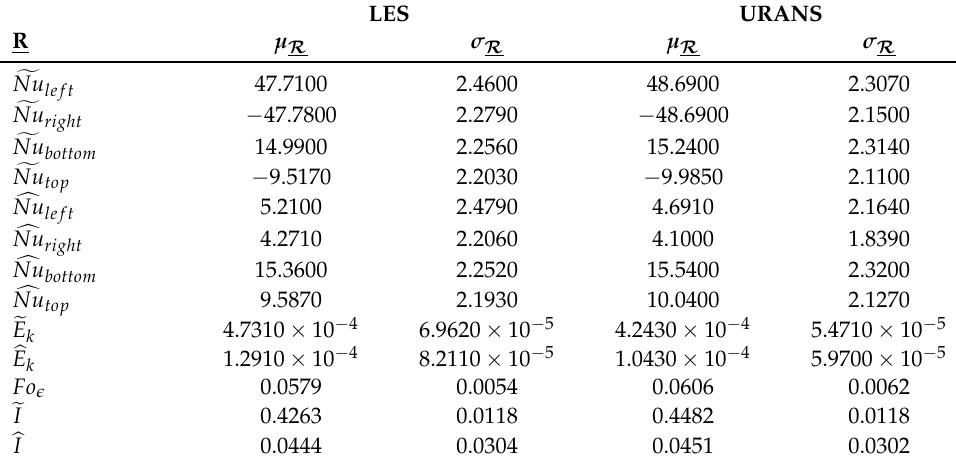
Table 3. Expansion mean µ R and standard deviation σ R for the random response R